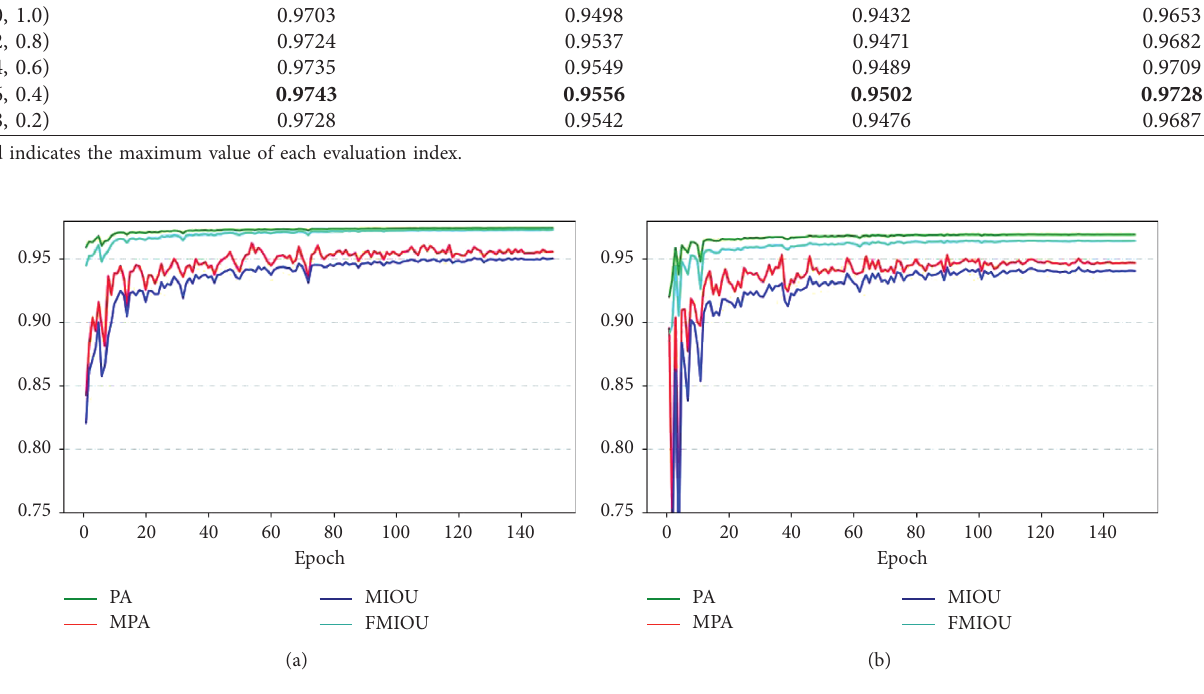
Figure 10: Each evaluation index iteration line diagram. (a) Each evaluation index iteration line diagram of CoANet. (b) Each evaluation index iteration line diagram of D-LinkNet.